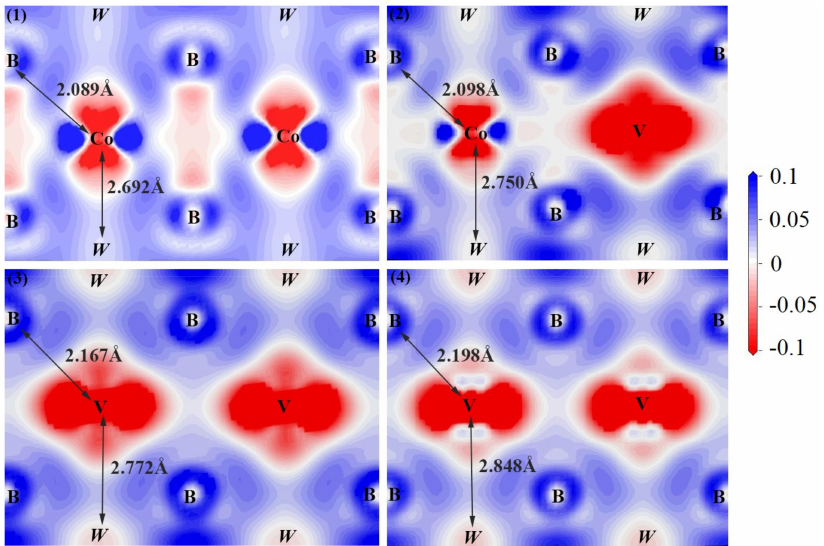
Figure 7. Illustration of charge density difference of V doped W 2 CoB 2 at different structure: ( 1 ) W 8 Co 4 B 8 -f; ( 2 ) W 8 Co 3 VB 8 -g; ( 3 ) W 8 Co 2 V 2 B 8 -h; ( 4 ) W 8 V 4 B 8